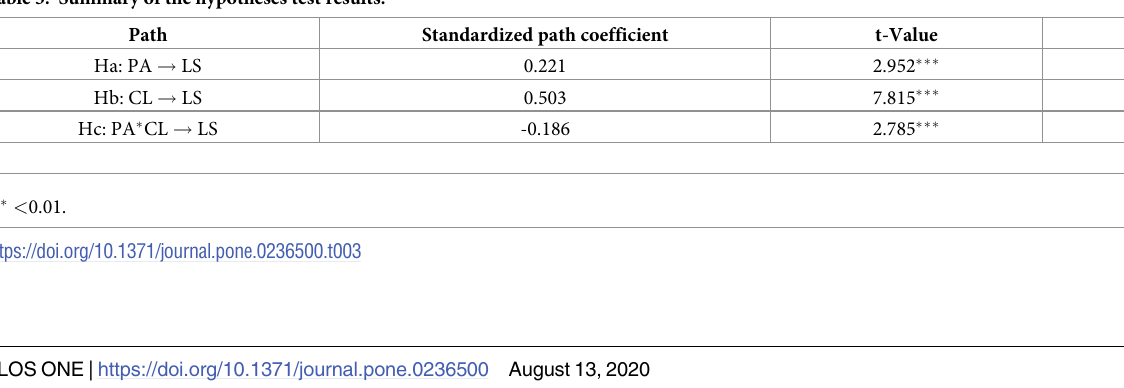
Table 3. Summary of the hypotheses test